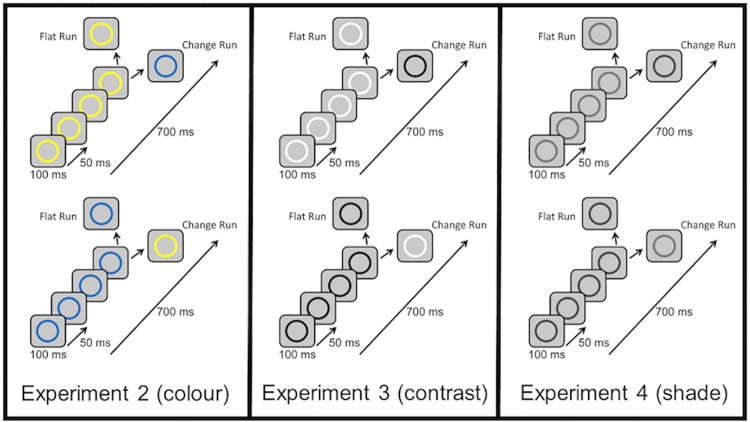
Annulus stimuli.All ring colors in the figure are approximations of ring colors presented to participants.